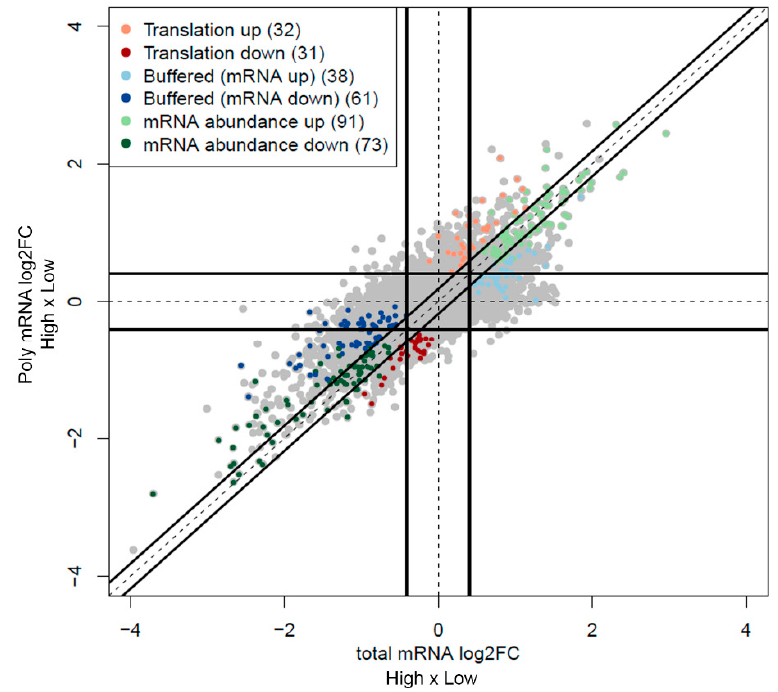
Figure 4. Representation of the di ff erentially transcribed and translated genes. Microarray expression data from total and poly mRNA was analyzed by anota2seq in the comparison of high- and low-grade fragments. Gene expression values in total and poly mRNA are plotted and the regulation modes are indicated by di ff erent colors (translation—orange and red, bu ff ering—light and dark blue, abundance— light and dark green).